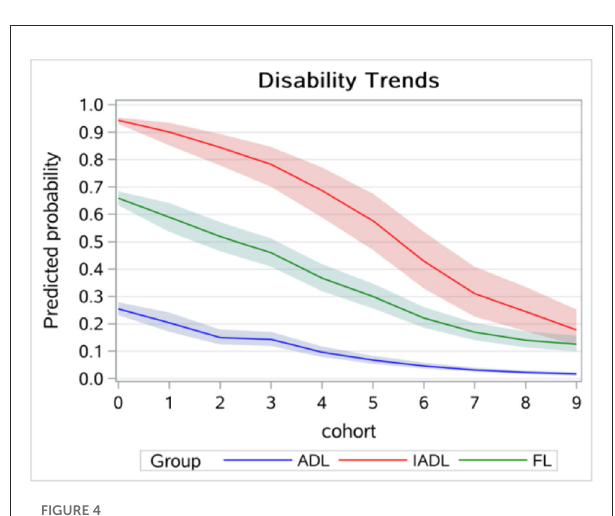
FIGURE4 Cohort trends in disability without controlling for age